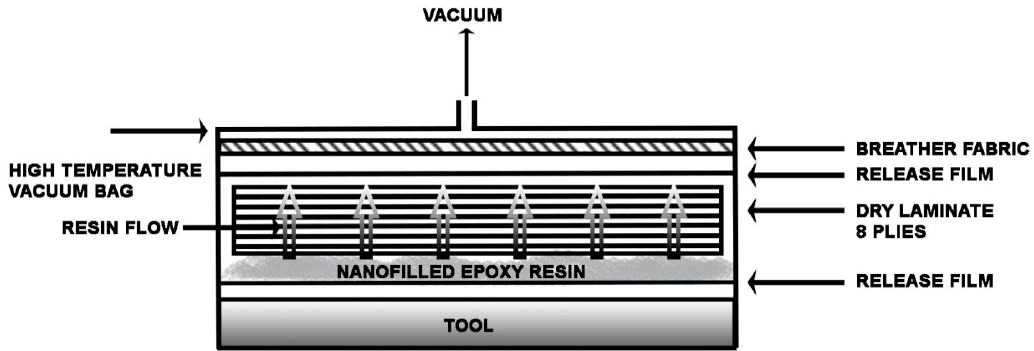
Figure 1. Vacuum bag preparation for the liquid infusion.